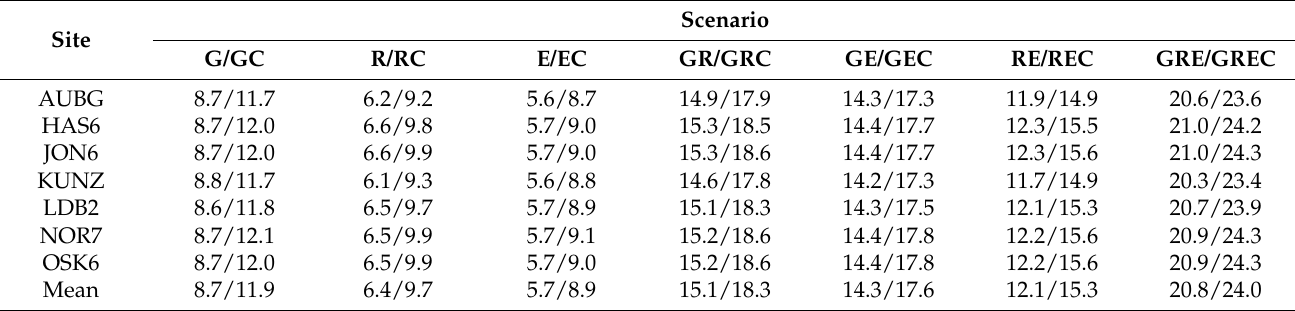
Table 4. Mean number of observed SVs (1 January 2021).